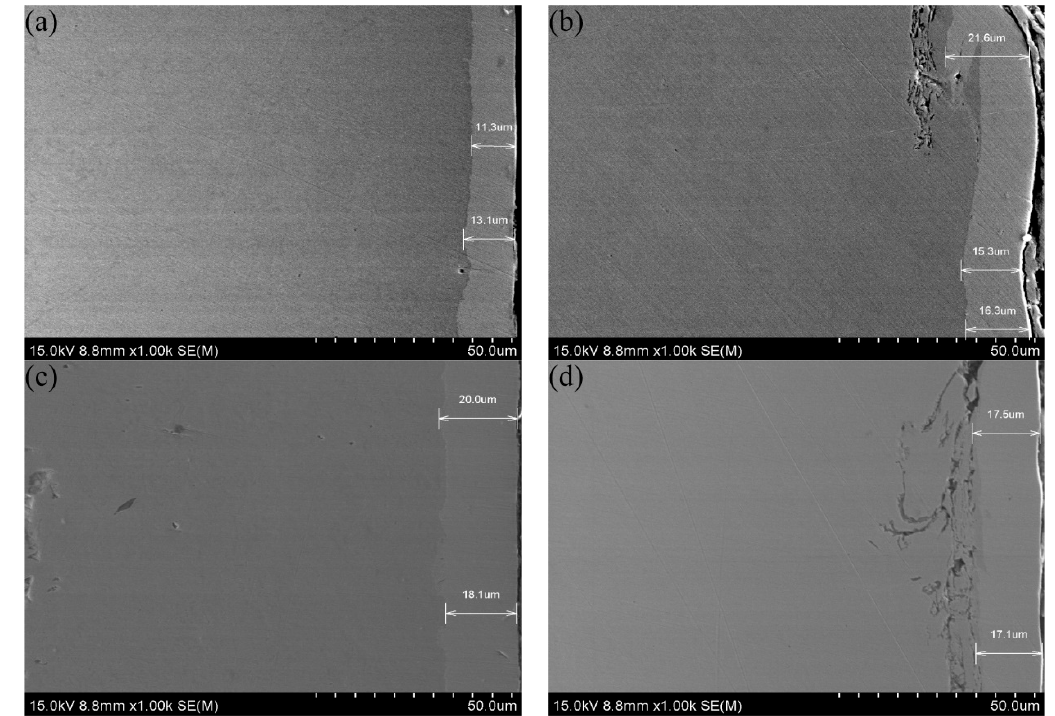
Figure 5. Section morphologies of the coatings prepared on 45 steel substrates by scanning electrodeposition with different pretreatment processes: ( a ) Ni–P(P), ( b ) Ni–P(S), ( c ) Ni–P–SiC(P), and ( d )